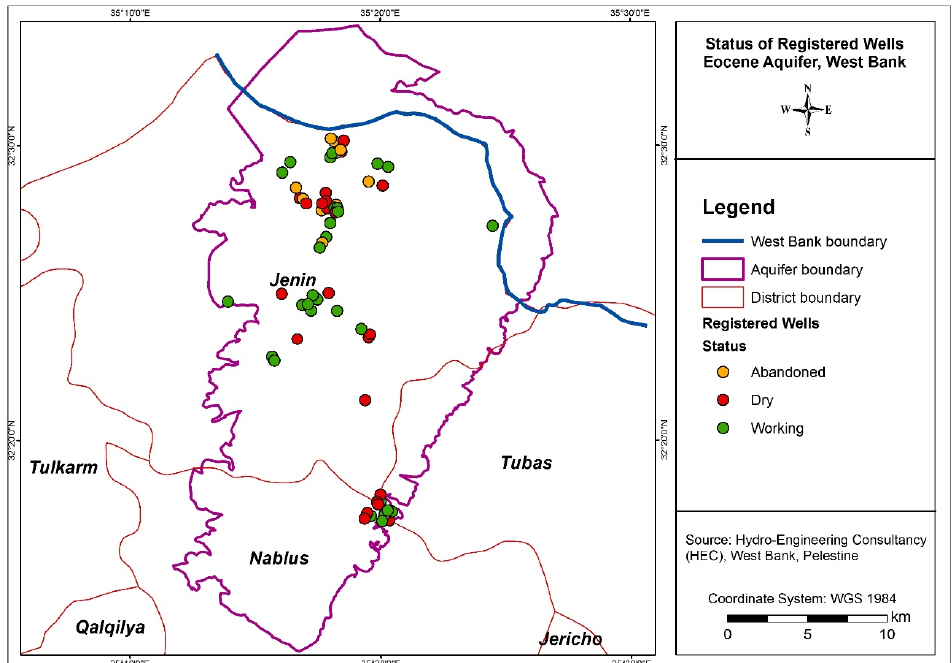
Figure 4. Registered wells in the Eocene aquifer area.